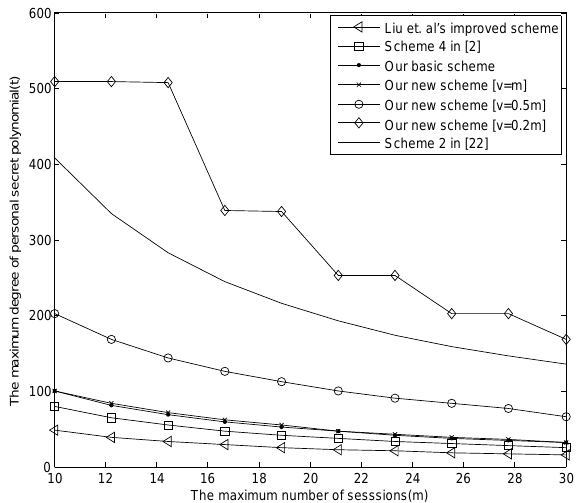
Figure 3. The trade-off between m and t as the size of the broadcast message is 64